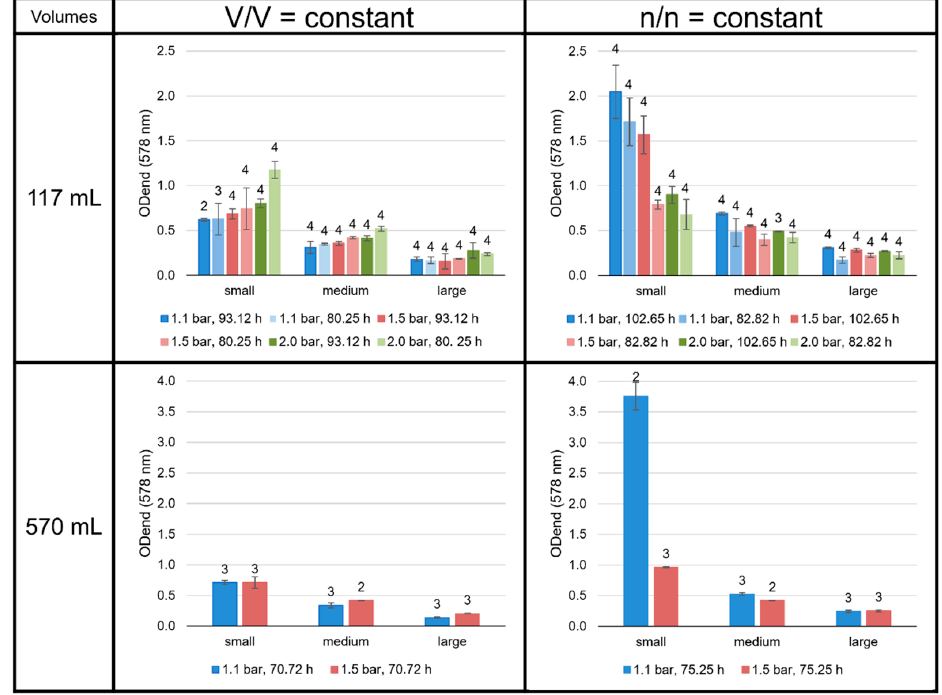
Figure 10. OD end (578 nm) of the M. marburgensis cultures. Pressure is given in bar relative to atmos- pheric pressure. Errors are standard deviations. Numbers above bars indicate number of samples.